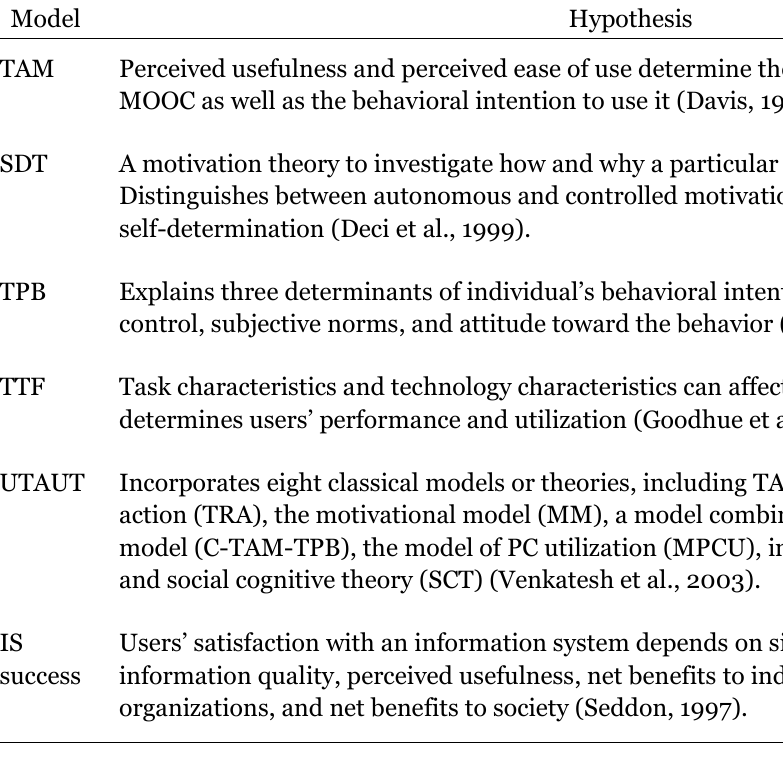
Table 2 Classical Models That Address Dropout Rates or Continuance Intention to Use MOOCs Model